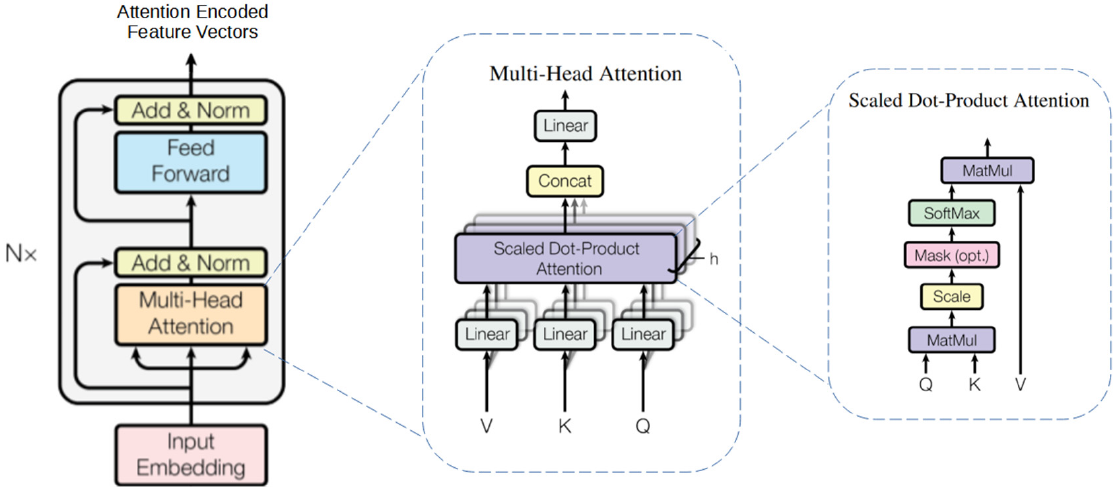
Figure 5. Multi-Head Attention Encoder.